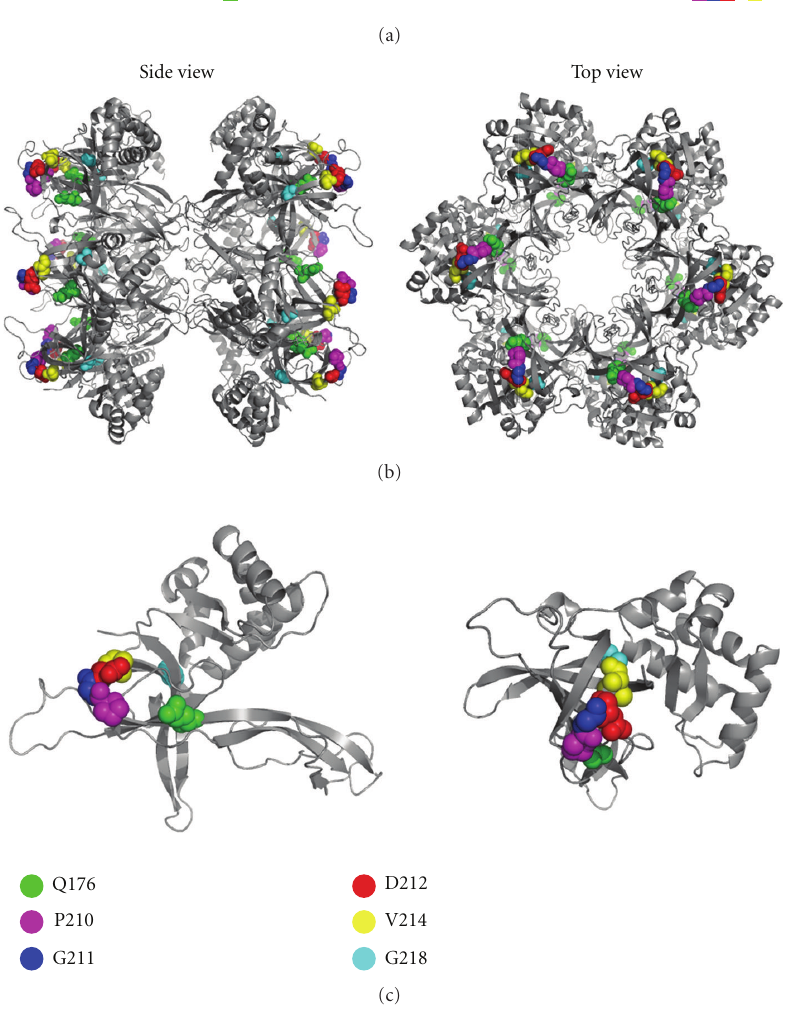
Figure 1: Locations of the amino acids mutated in the study. (a) An alignment of the amino acid sequences of the region of domain C analyzed in the study. The residues mutated are shown in color. Q176 (green), P210 (magenta), G211 (blue), D212 (red), V214 (yellow), G218 (cyan). The accession numbers used are: Methanothermobacter thermautotrophicus , NP 276876; Picrophilus torridus , YP 023995; Methanosarcina mazei , NP 633860; Sulfolobus tokodaii , NP 376352; Archaeoglobus fulgidus , NP 069353; Halobacterium , NP 280836. (b) Side and top views of the three-dimensional structure of the dodecameric N-terminal portion of the M. thermautotrophicus MCM protein (PDB ID: 1LTL [4]) are shown. The mutated residues are highlighted in colors as in (a). (c) Side and top views of the three-dimensional structure of the monomeric N-terminal portion of the M. thermautotrophicus MCM protein (PDB ID: 1LTL [4]) are shown. The mutated residues are highlighted in color as in